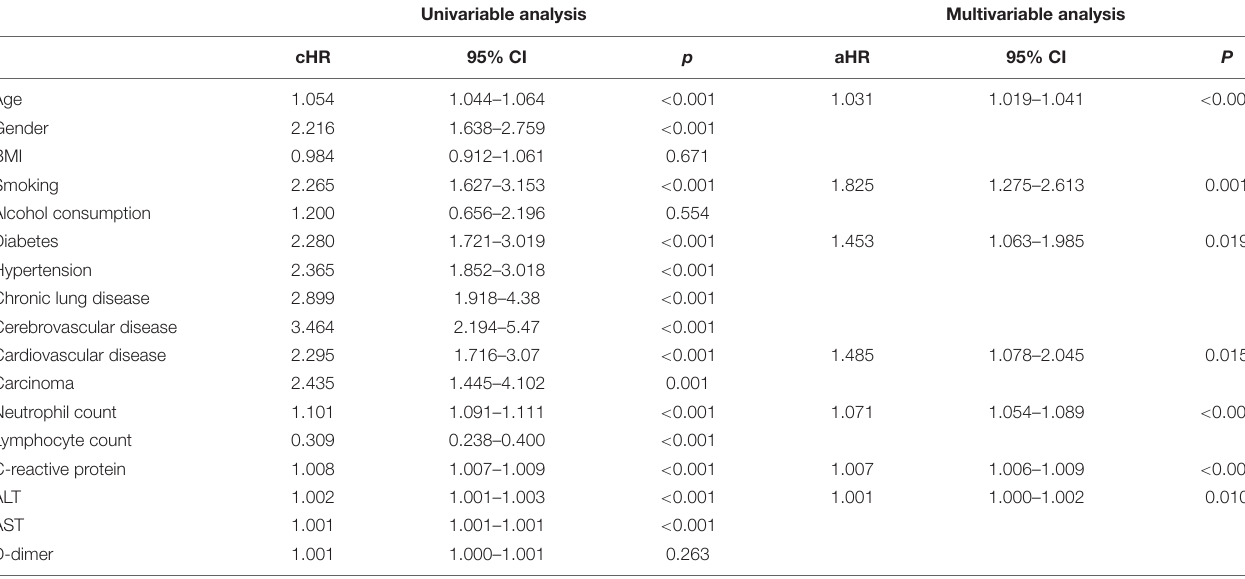
TABLE 3 | Risk factors associated with mortality by cox